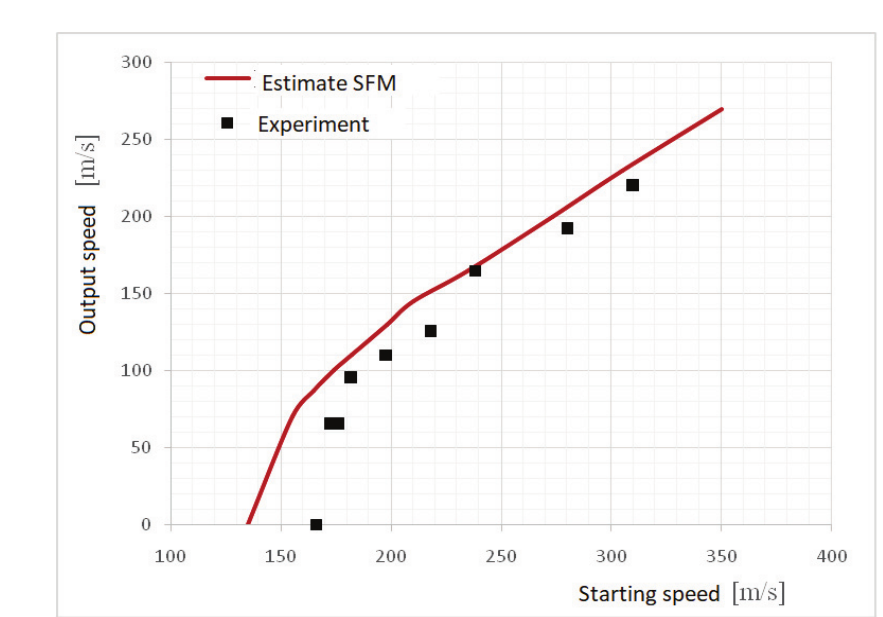
Figure 8 – Analysis of the SFM by a blunt projectile for a plate with a thickness of 10 mm Рис . 8 – Анализ SFM тупоконечным снарядом на плиту , толщиной 10 мм Слика 8 – Анализа СФМ тупим пројектилом за плочу дебљине 10